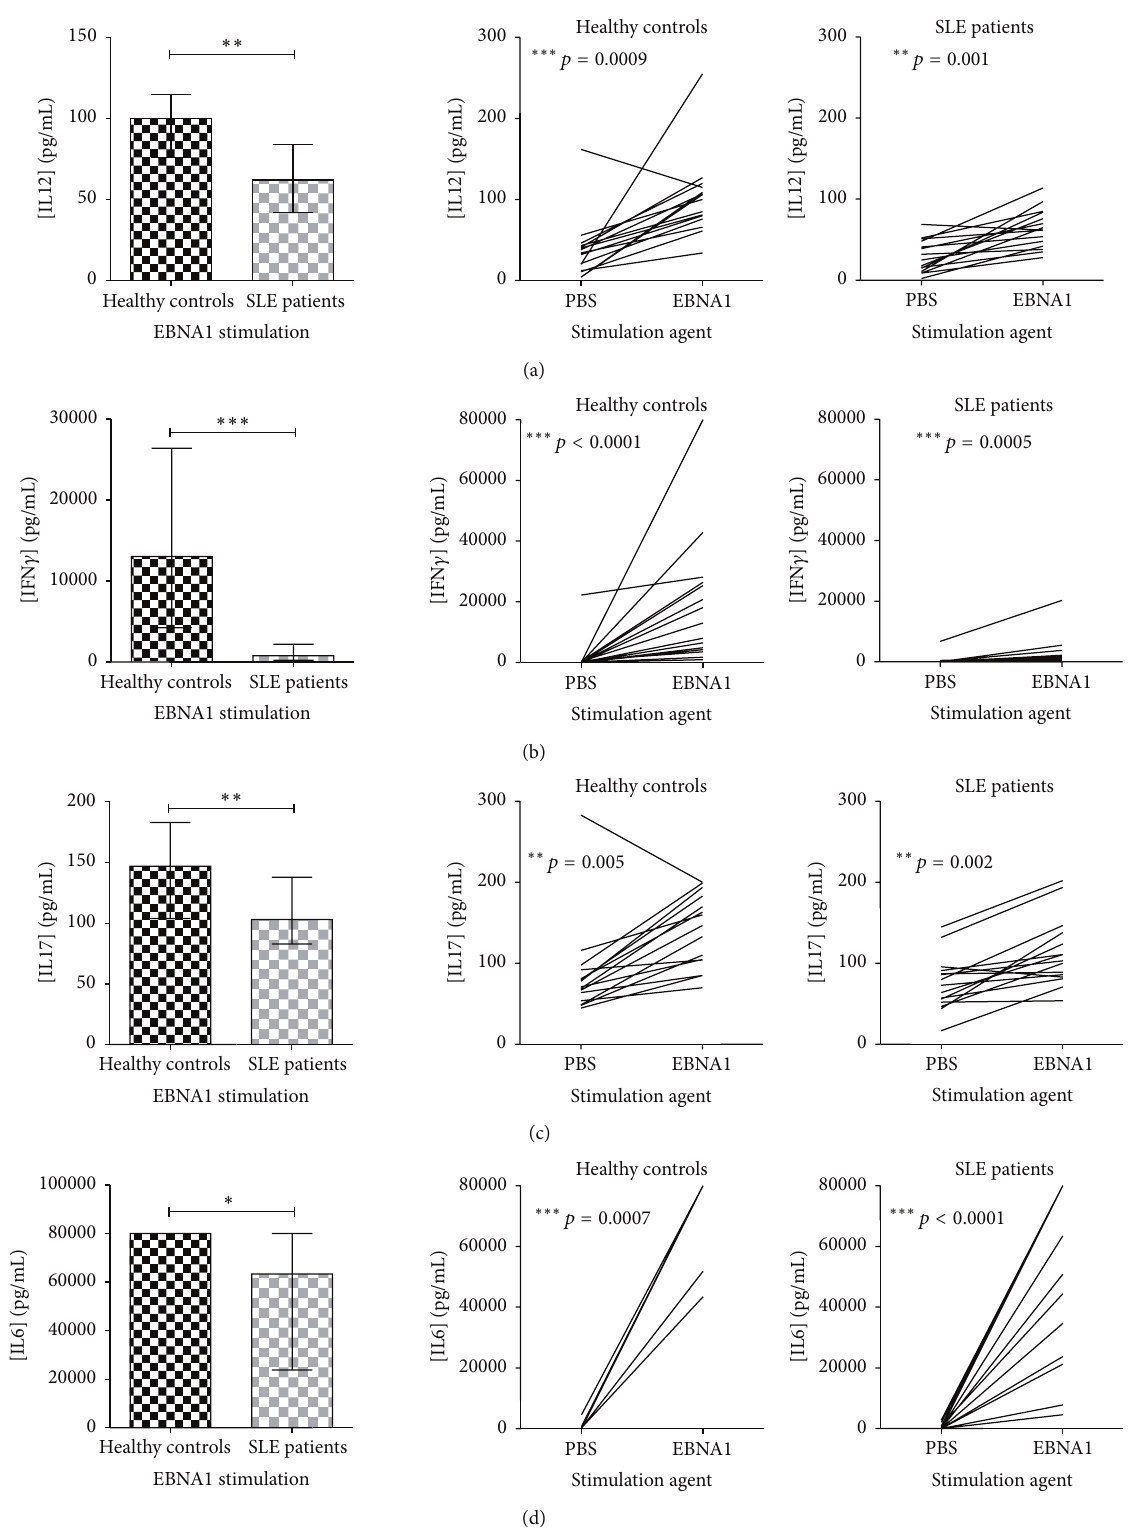
Figure 1: Decreased induction of IL12 (a), IFN 𝛾 (b), IL17 (c), and IL6 (d) in SLE patients compared to HCs upon EBNA1 stimulation. IL12 (a), IFN 𝛾 (b), IL17 (c), and IL6 (d) quantified in dried blood spot samples from SLE patients (with normal lymphocyte levels, 𝑛 = 15 ) and sex- and age-matched HCs ( 𝑛 = 15 ) by multiplexed Luminex assay with addition of HBR+. Left: cytokine concentrations (pg/mL) in SLE patients and HCs upon EBNA1 stimulation. Data are presented as median with interquartile range. 𝑝 values for comparison of SLE patients and HCs are 0.009, < 0.0001, 0.003, and 0.027 in (a), (b), (c), and (d), respectively. Right: induction of cytokines (pg/mL) from basic levels (PBS stimulation) by EBNA1 stimulation in SLE patients and